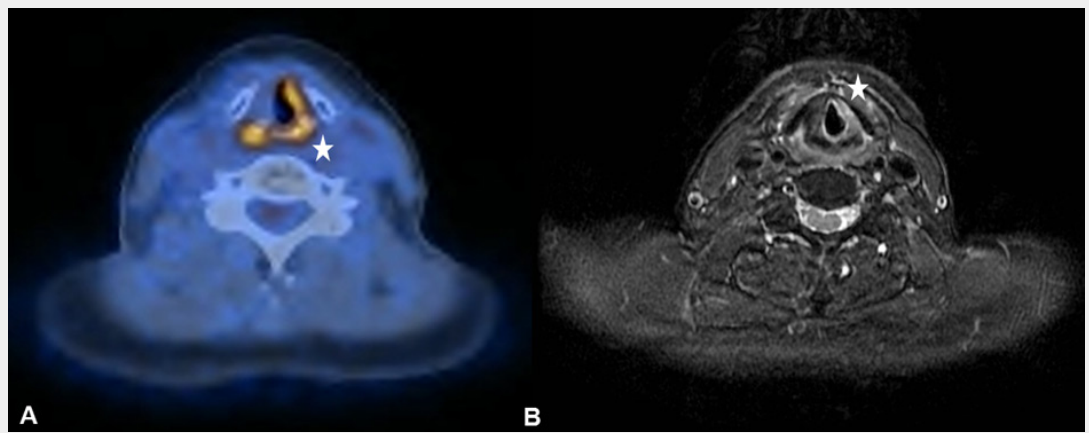
Figure 3 (A) Compensatory uptake in the left vocal cord in a 59-year old patient with known right unilateral vocal cord immobility due to a transglottic larynx carcinoma. (B) The corresponding T2-weighted magnetic resonance imaging examination helps to better delineate the immobile right vocal cord by providing superior soft-tissue